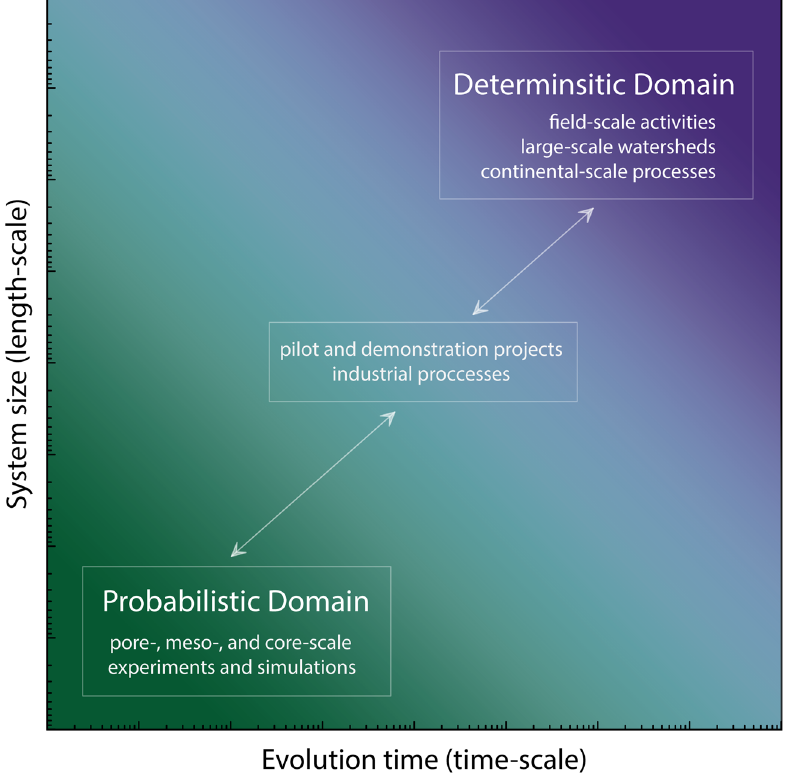
Figure 7. A conceptual framework specifying probailistic and determisntic domains to predict mineral nucleation for various spatiotemporal scales. The induction time determines the boundary between the probabilistic and deterministic domain (transition